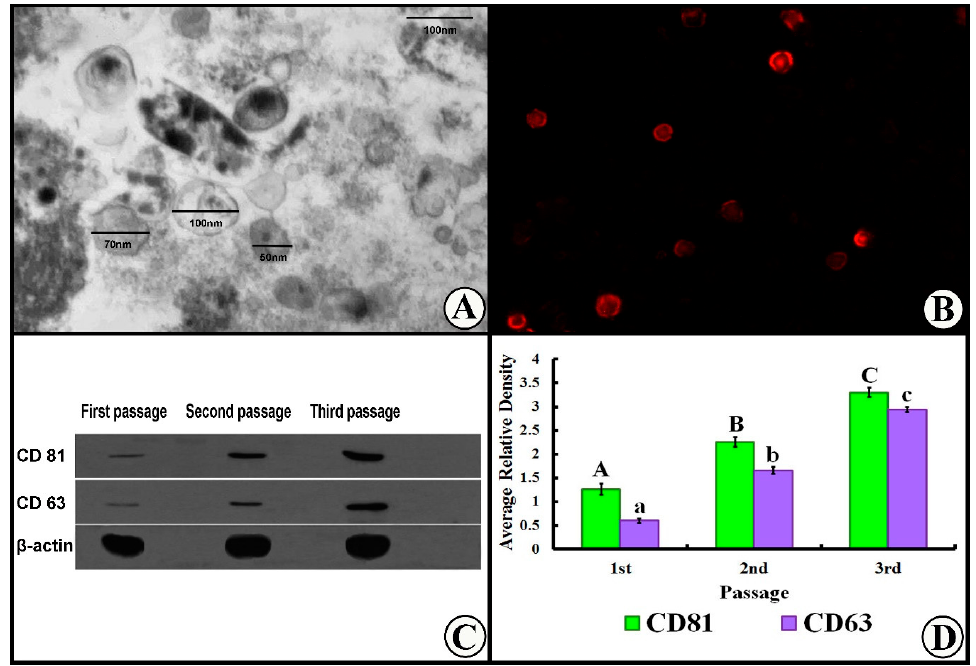
Figure 2. ( A ) TEM of exosomes showed spheroid double-membrane bound morphology (arrows) with a diameter of 40–100 nm. ( B ) Exosomes were also detected in renal tissues by PKH26. ( C ) Western blot for exosome characterization. ( D ) Histogram of exosome characterization. For CD81 panel, means with uppercase letters (A, B, and C) indicate significant differences at p ˂ 0.05. For CD63 panel, means with lowercase letters (a, b, and c) indicate significant differences at p ˂ 0.05. Data are shown as mean ± SEM, n = 5.